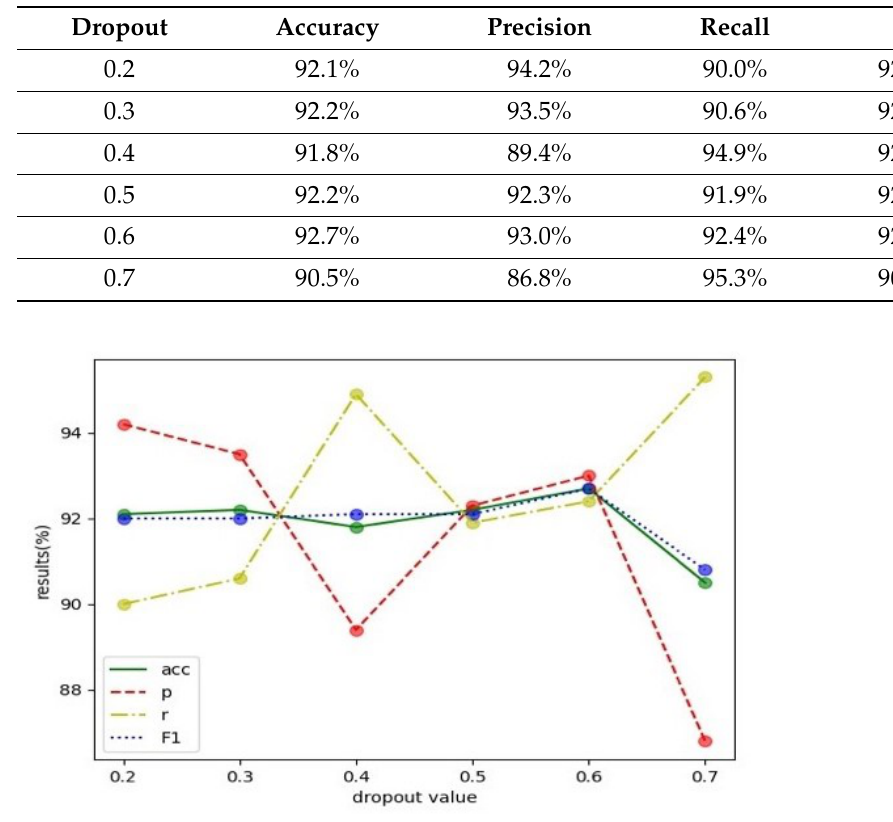
Figure 7. Experimental results of text